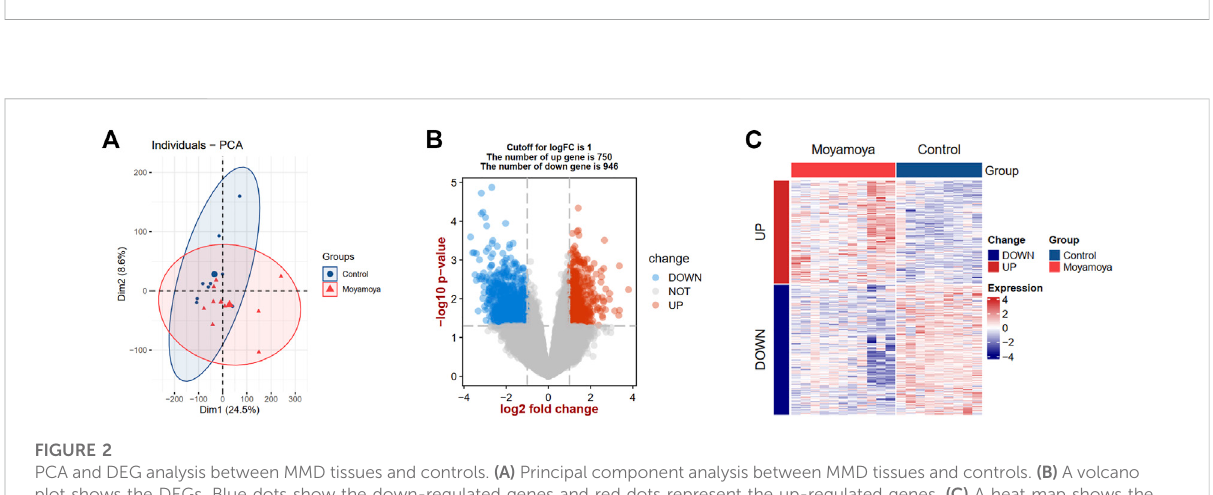
FIGURE 1 Flow chart of the study. DEGs,differentially expressed genes; GSEA, gene set enrichment analysis; ssGSEA, Single sample gene set enrichment; GSVA, gene set variation analysis; GO: BP, Gene Ontology: biological processes; KEGG, Kyoto Encyclopedia of Genes and Genomes; DO, Disease Ontology;ARGs,autoimmune-relatedgenes;DEARGs,differentiallyexpressedautoimmune-relatedgenes;LASSO,theleastabsoluteshrinkage and selection operation; RF, random forest; SVM-RFE, Support vector machine-recursive feature elimination; ML, machine learning; BP neural network, back propagation neural network; ROC, Receiver operating characteristic curve.